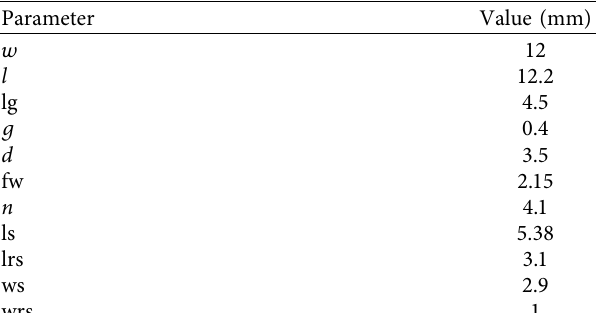
Table 2: Antenna dimensions.